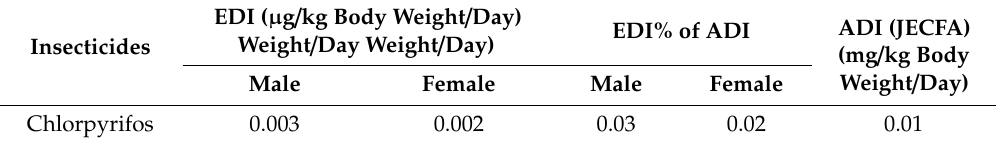
Table 4. EDI levels of organophosphorus insecticide residues in Taiwanese